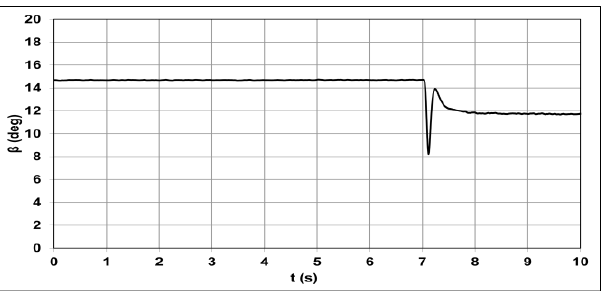
Figure 11. Changes in the attack angle of the blades after including the farm in frequency regulation.